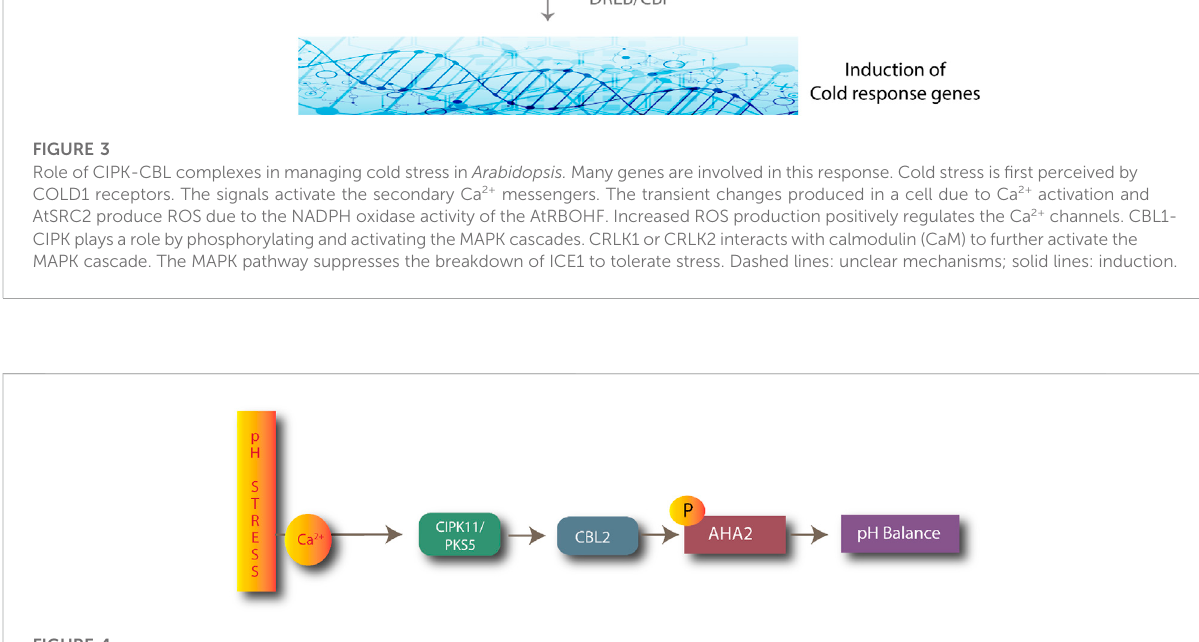
FIGURE 4 Process of maintaining pH balance by CBL2-CIPK11 complexes after activation of AHA